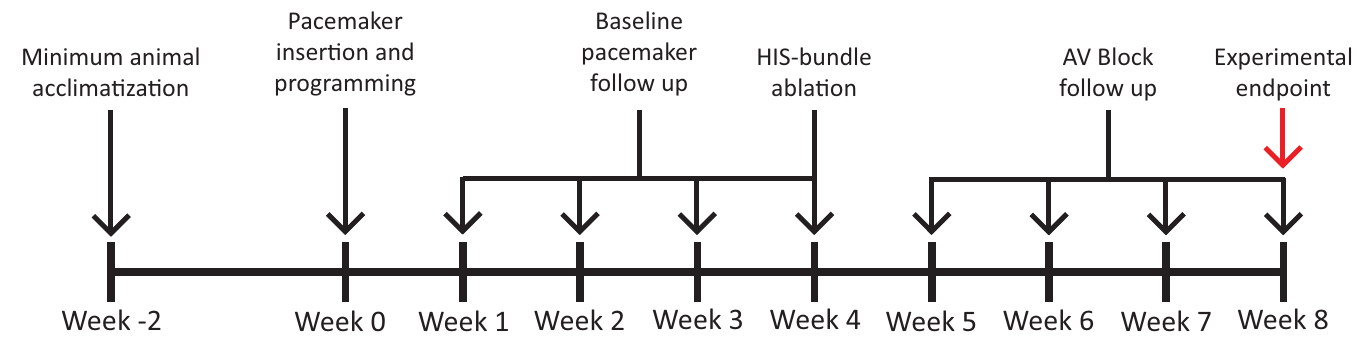
Fig 1. Experimental timeline depicting the stages at which the sheep were subjected to pacemaker insertion, His bundle ablation and monitoring for data collection.